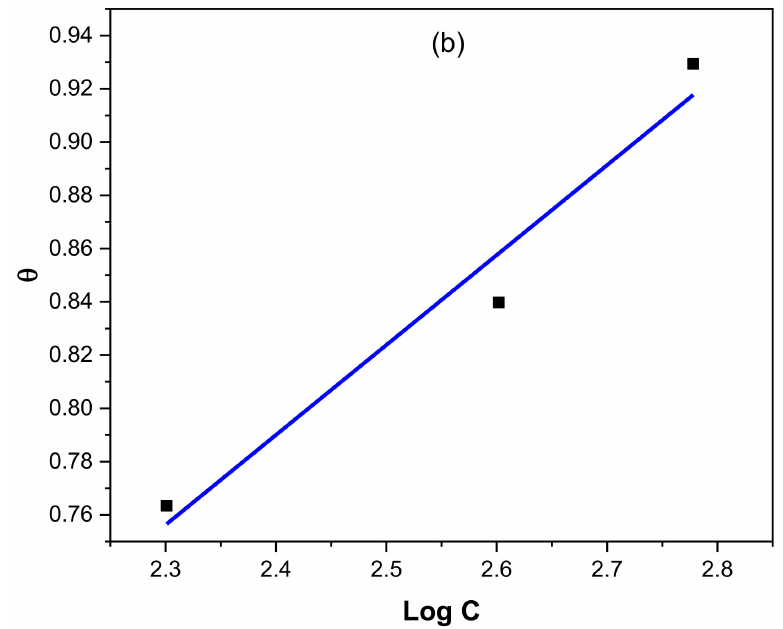
Figure 15. ( a ) Langmuir and ( b ) Freundlich adsorption isotherm model for adsorption of PBSLP onto the mild steel surface in 1 M HCl containing di ff erent inhibitor